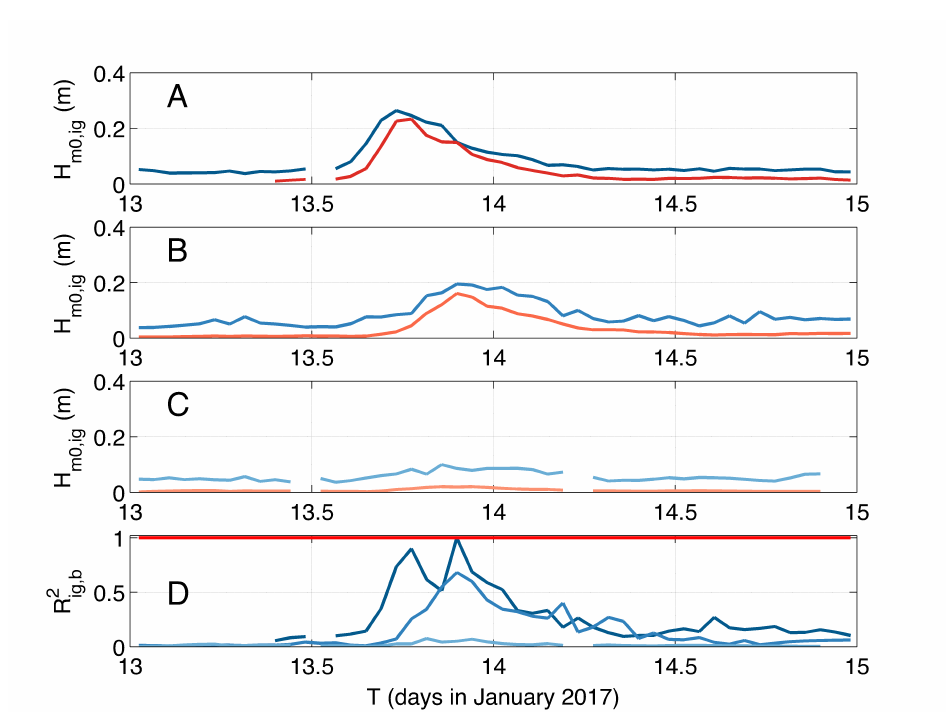
Figure 6. IG conditions during storm Egon at A12 (dark blue), Q1 (blue) and EUR (light blue). ( A ) Bound (red) and total (blue) IG wave height at A12. ( B ) Bound (red) and total (blue) IG wave height at Q1. ( C ) Bound (red) and total (blue) IG wave height at EUR. ( D ) Ratio of the predicted bound IG variance over the observed IG variance where the red line corresponds to zero